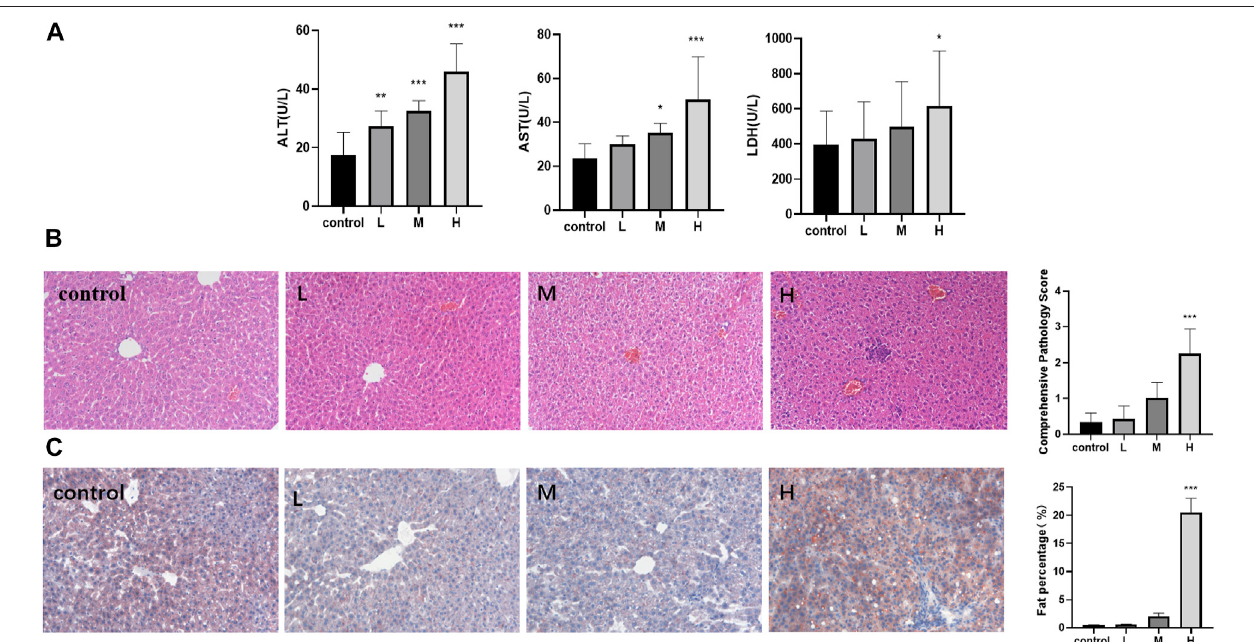
FIGURE1| TWinducedliverinjuryinC57BL/6Jmice. (A) TW-inducedelevationofALT,AST,andLDH. (B) TW-inducedpathologicalchangesandcomprehensive pathological scores by H&E staining. (C) TW-induced liver tissuefat accumulation and fat percentage by Oil red Ostaining. Compared with the control group, *p < 0.05, **p < 0.01, ***p <